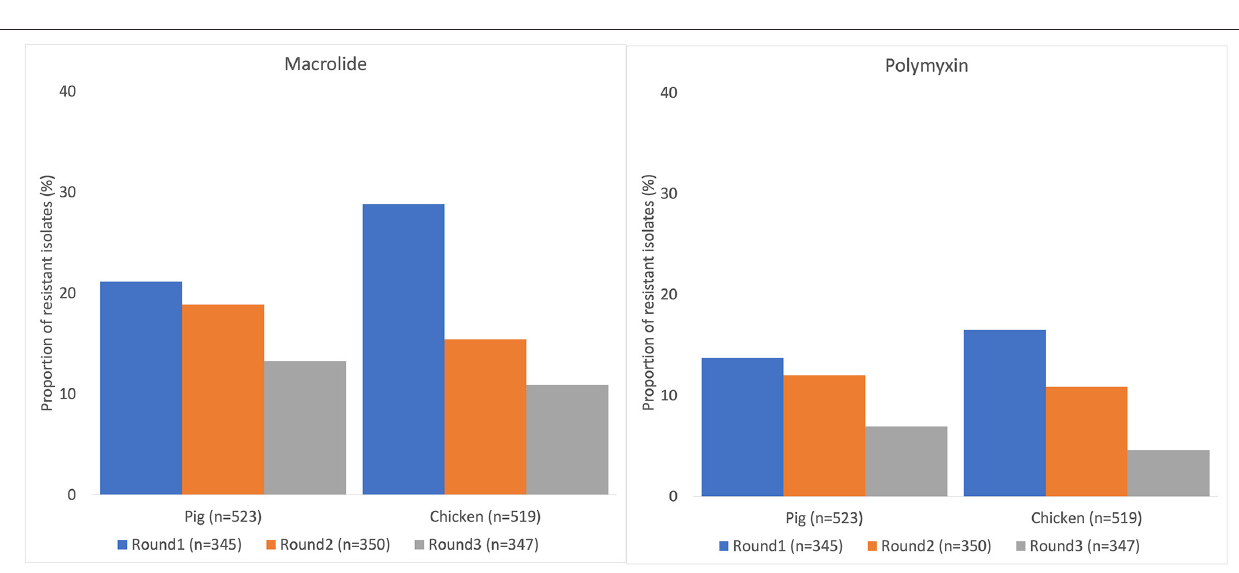
Frontiers in Veterinary Science |